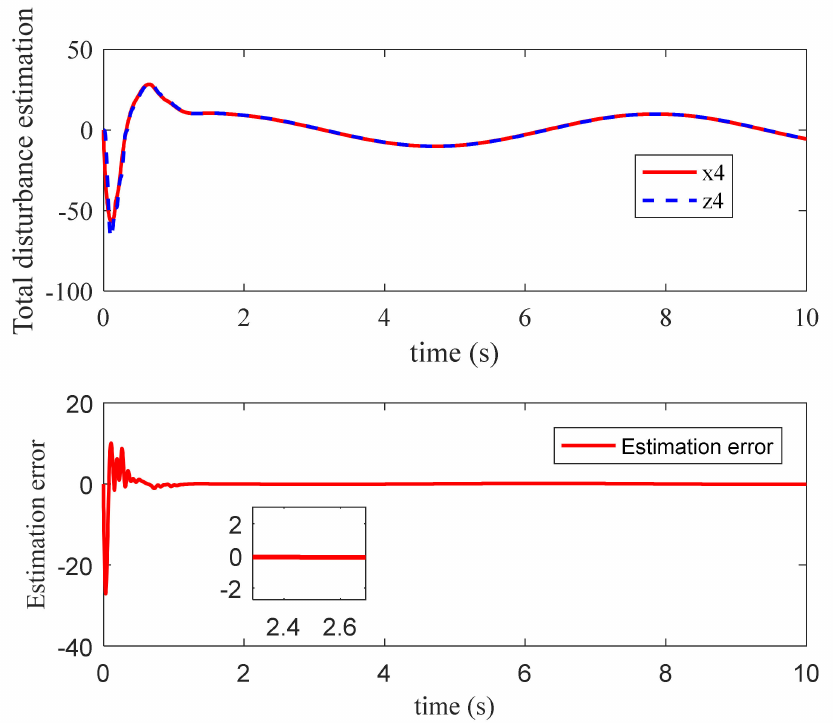
Figure 8. Time response and estimation error of observer for total disturbance. ( x 4 and z 4 rep- resent the practical total disturbance of the system and the corresponding state estimated by the observer,